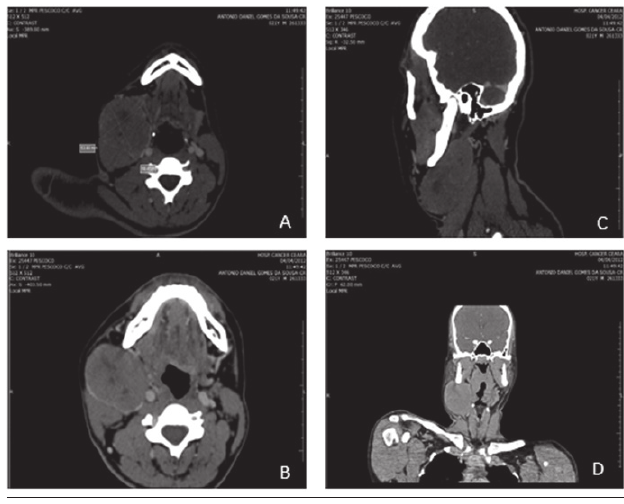
FIguRE 6 − Head and neck CT images Post contrast CT images show a well-defined cervical mass stage II and III on the right side extending to the soft palate measuring approximately 6.0 cm, with moderate heterogeneous enhancement. A) and B) axial CT image; C) sagittal CT image; D) coronal CT image. CT: computed tomography.